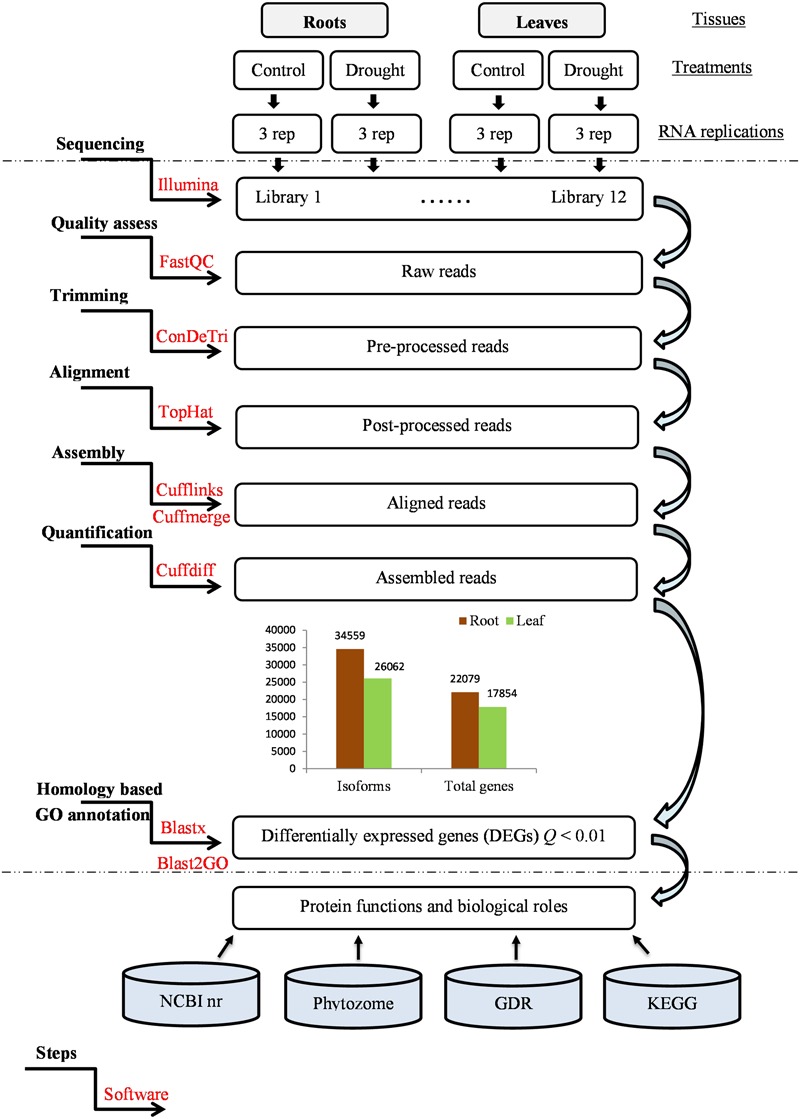
RNA-seq pipeline.